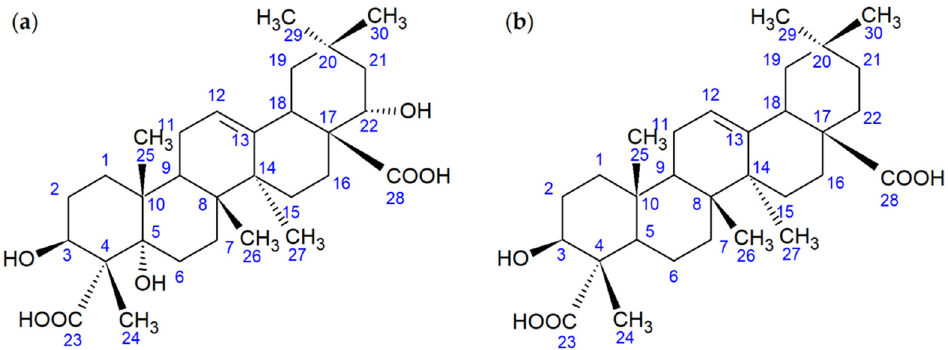
Figure 8. Structural formulas of the OA metabolite ( a ) and gypsogenic acid ( b ).